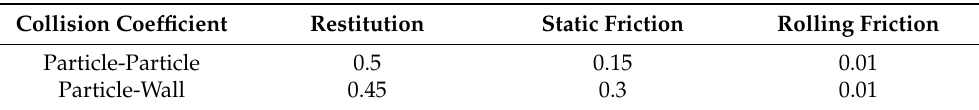
Table 3. Collision